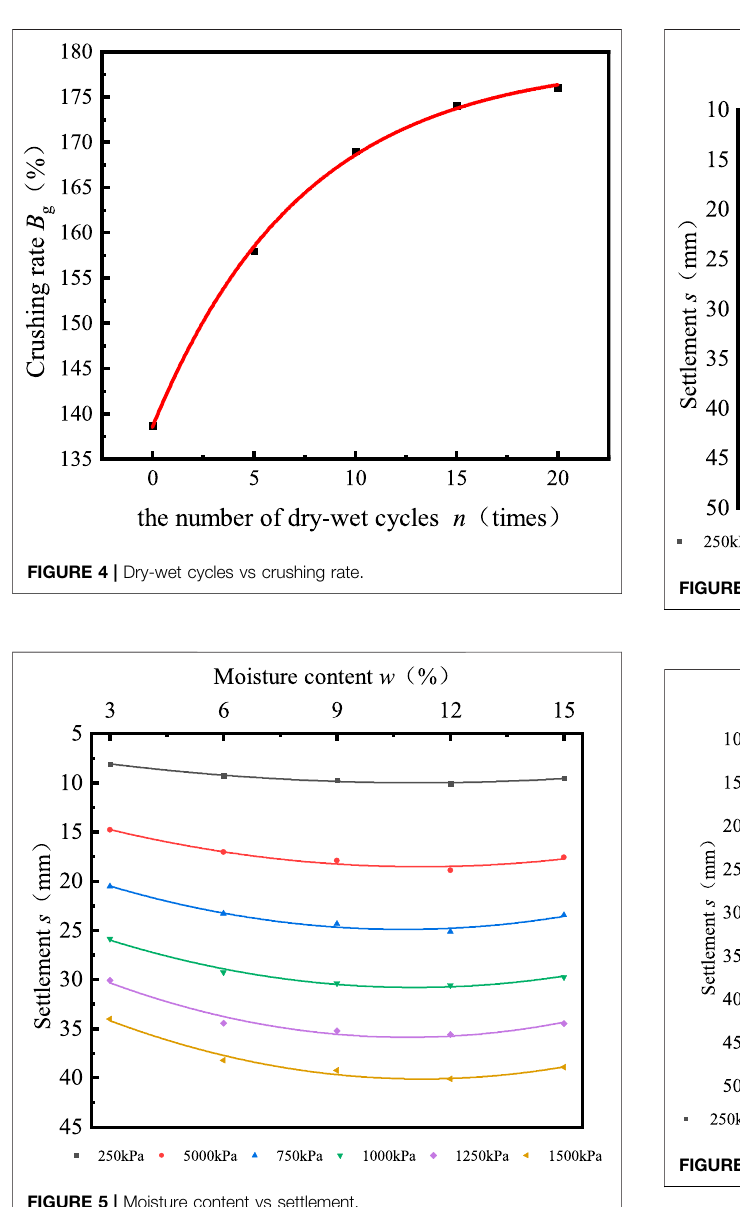
FIGURE 5 | Moisture content vs settlement.